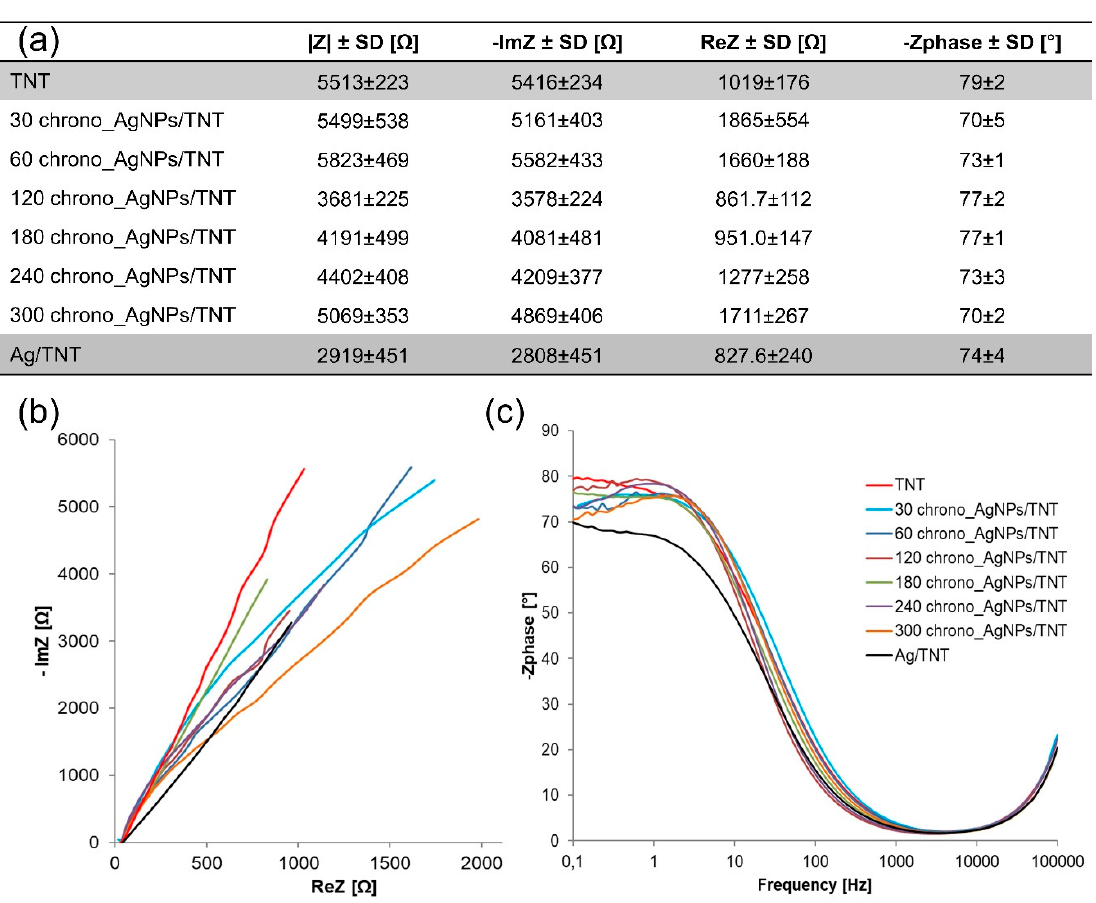
Figure 7. Summary of impedance parameters ( a ), Nyquist ( b ) and Bode ( c ) plots of AgNPs / TNT platforms differing in time of silver nanoparticles deposition and reference layers: TNT and Ag/TNT. Spectra were recorded in the PBS solution (0.01 M, 10 ml, pH 7.4) over the frequency range 0.1–10 5 Hz with amplitude 10 mV.